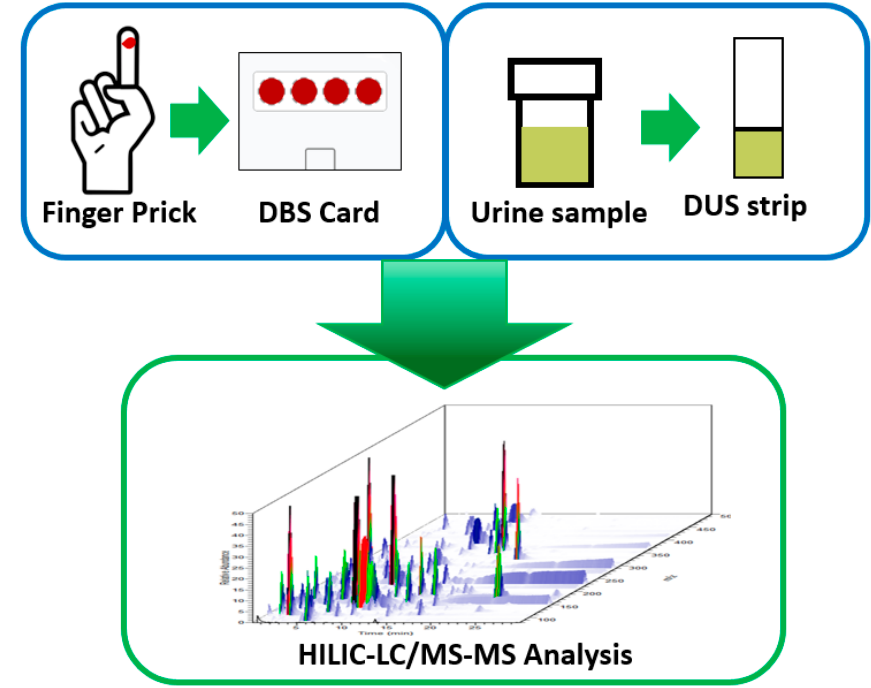
Figure 1. Schematic of human metabolome analysis using DBS/DUS sampling protocols.